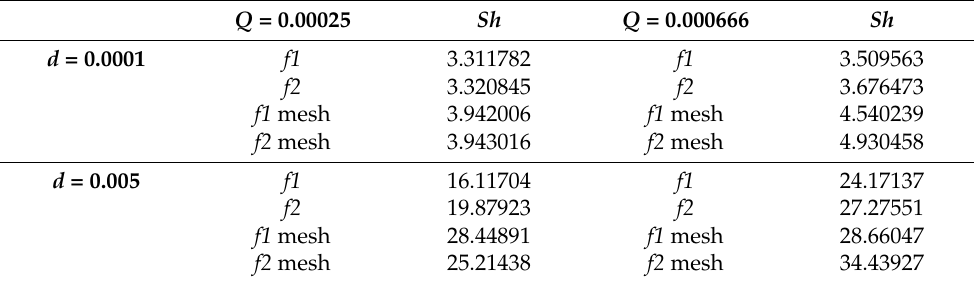
Table 1. The average values of the mass transfer coefficient Sh.